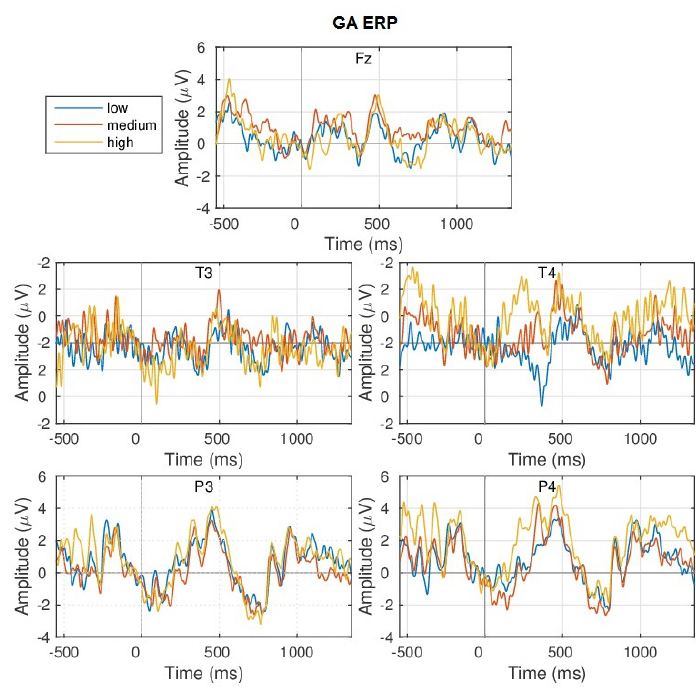
Figure A1. Grang Average (GA) ERPs for Nat images on 3 complexity levels according to CFD: low (blue), medium (red) and high (orange) complexity, for all